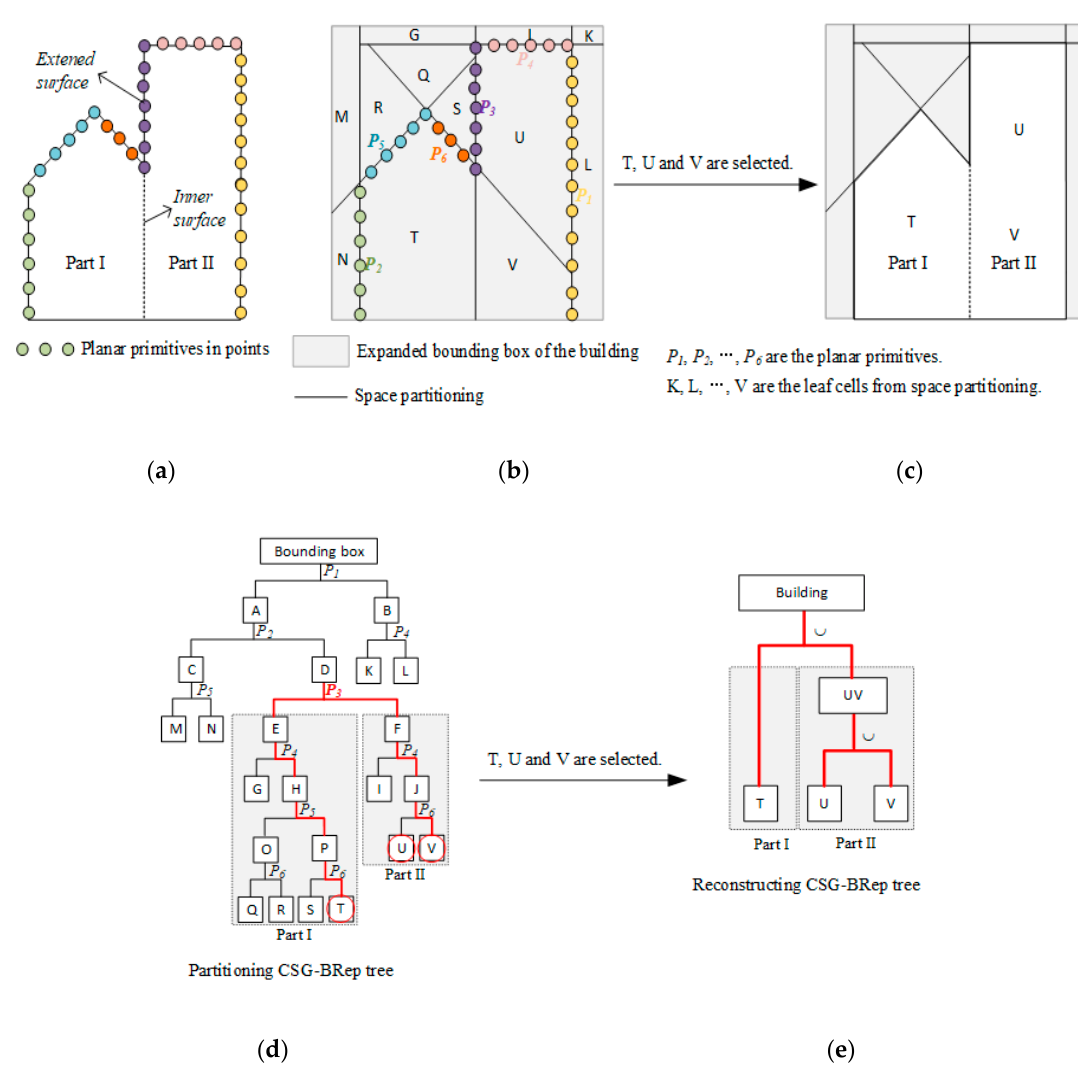
Figure 10. Illustration of the topology analysis between building parts. ( a ) A 2D diagram of a building with two parts and the inner surface between the two parts; ( b ) the space partitioning based on planar primitives P 1 , P 2 , …, P 6 , and the partitioning CSG-BRep tree shown in ( d ); ( c ) the building model formed by the reconstructing CSG-BRep tree shown in ( e ). The planar primitive P 3 is the extended surface of the inner surface, and the branches created by P 3 in the partitioning tree and the reconstructing tree correspond to the different parts of the building.